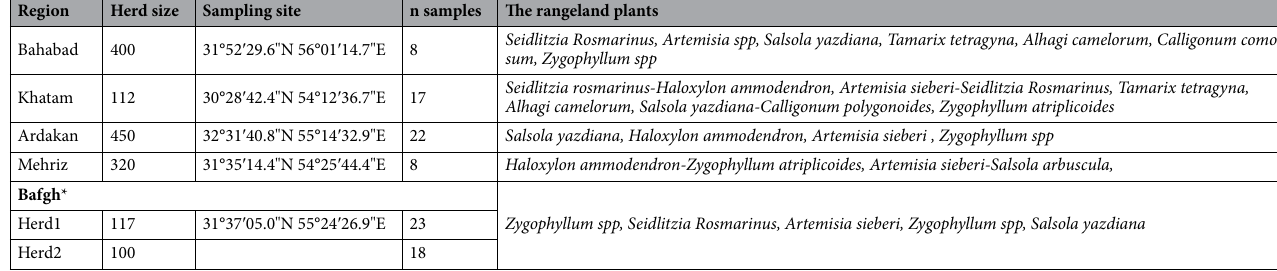
Table 1. Characteristics of sampling herds and the rangeland plants. *Two herds in Bafgh were recorded (1: local herd and 2: National Research and Development Station on Dromedary Camel herd).